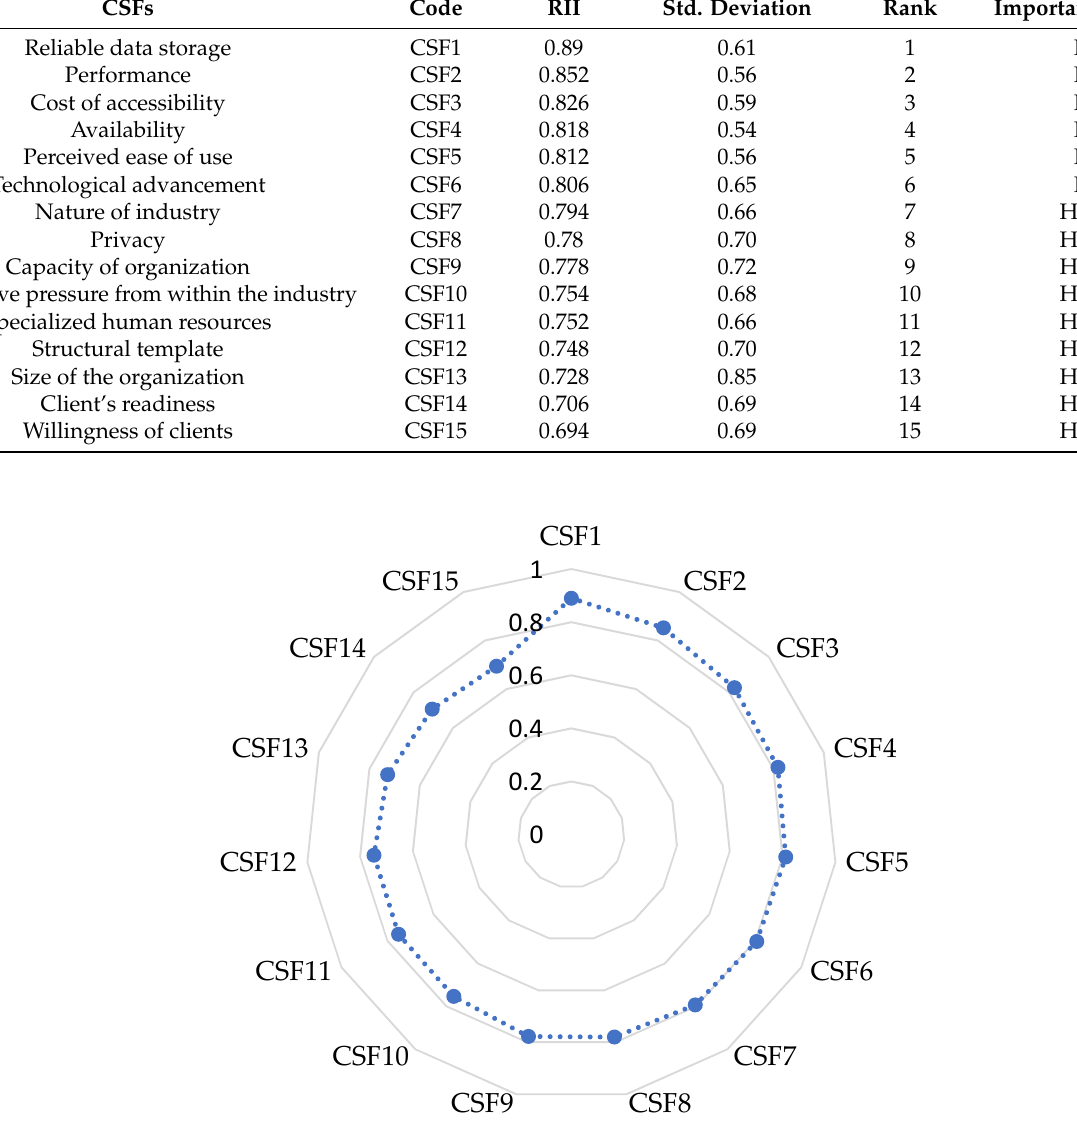
Figure 2. RII levels for cloud computing CSFs.